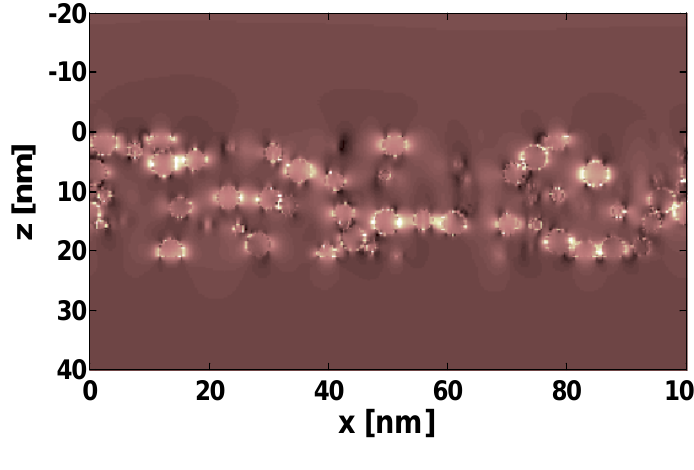
Figure 2. Amplitude of the electric field in a cross section through the